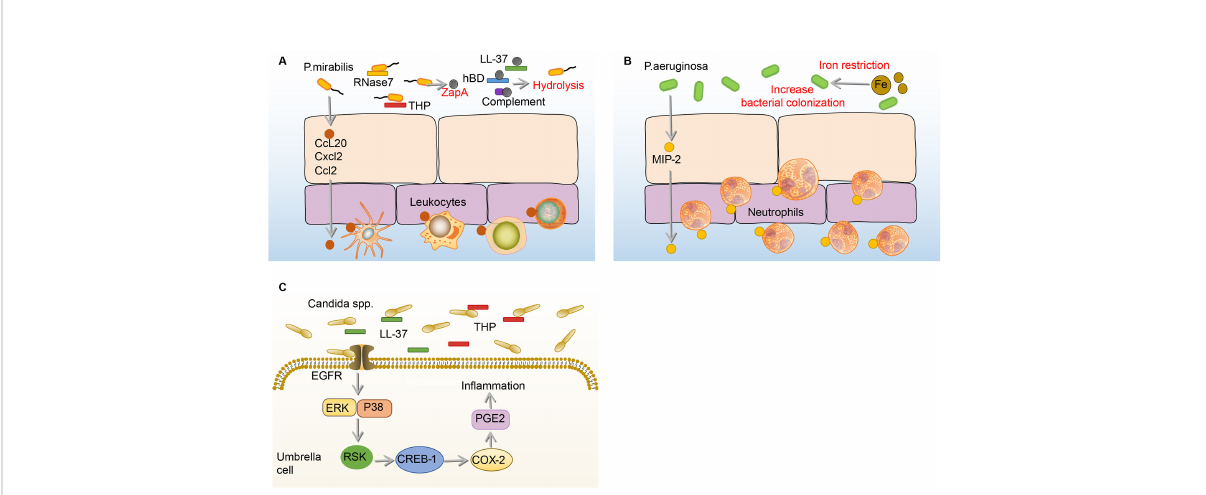
FIGURE 6 Immune responses to P. mirabilis , Paeruginosa and Candida spp. in the bladder. (A) Before adhesion, THP and RNase 7 resist the adhesion and invasion of P.mirabilis to the bladder, and P.mirabilis has countermeasures by expressing extracellular metalloprotease ZapA, which has hydrolytic activity. In addition, ZapA can hydrolyze complement (C1q and C3), LL-37, and human hBD in the urine. Notably, BECs can produce CCL20, CXCL2, and CCL2, and then promote numbers of leukocytes migrate to the epithelium, the speci fi c role of which is not determined. (B) Under the iron restriction, P.aeruginosa has a stronger colonization ability on BECs. Once P.aeruginosa adheres to the BECs, the BECs increase the expression of MIP-1 a to recruit neutrophils, which against the bladder infection of P.aeruginosa . (C) In the urine, THP and LL-37 respectively bind to the Als3 and Xog1p glycoprotein of Candida to inhibit adhesion. After Candida adhesion, BECs express COX-2 through EGFR-ERK/p38-RSK-CREB-1 pathway, leading to the synthesis of prostaglandins, which mediate the occurrence of in fl ammation. BECs, bladder epithelial cells; Candida, Candida spp; CCL20, c-c chemokine ligand 20; COX-2, cyclooxygenase-2; CREB-1, cAMP-response element-binding protein-1; CXCL2, C-X-C motif chemokine ligand 2; EGFR, epidermal growth factor receptor; ERK, extracellular regulated protein kinases; hBD, b -defensin; MIP-1 a , macrophage in fl ammatory protein-1 a ; P.aeruginosa , Pseudomonas aeruginosa ; P. mirabilis , Proteus mirabilis ; RNase 7, ribonuclease 7; RSK, ribosomal s6 kinase; THP, tamm-horsfall